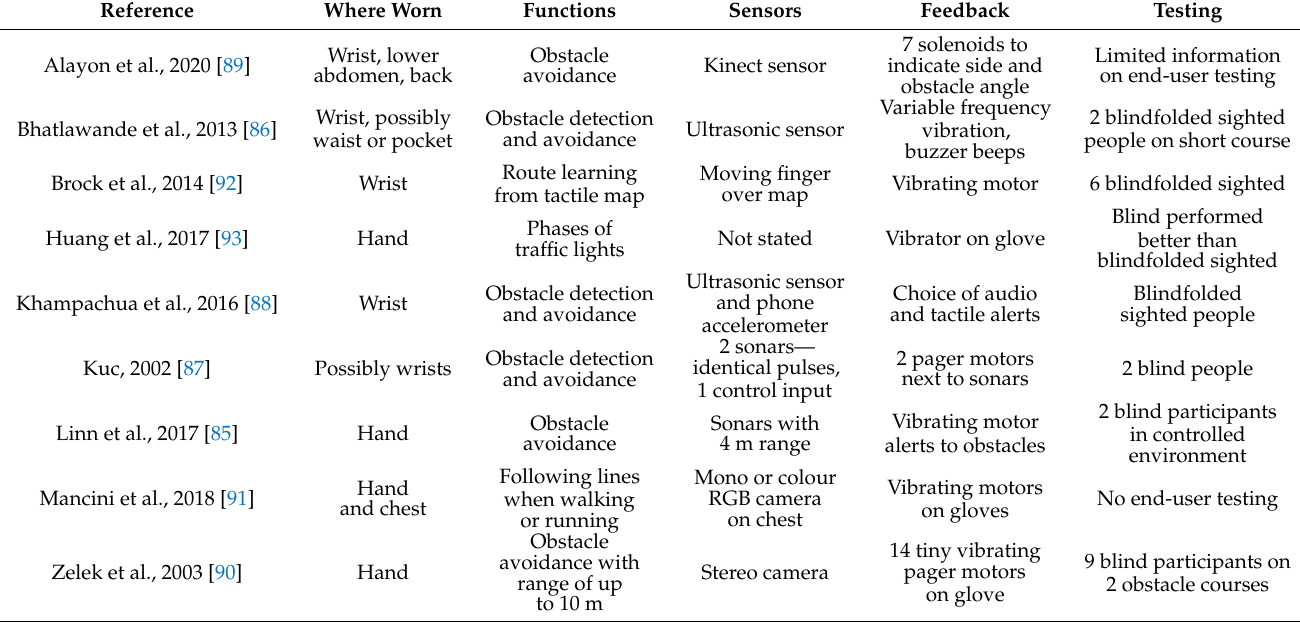
Table 4. Device features and testing for hand and arm-worn